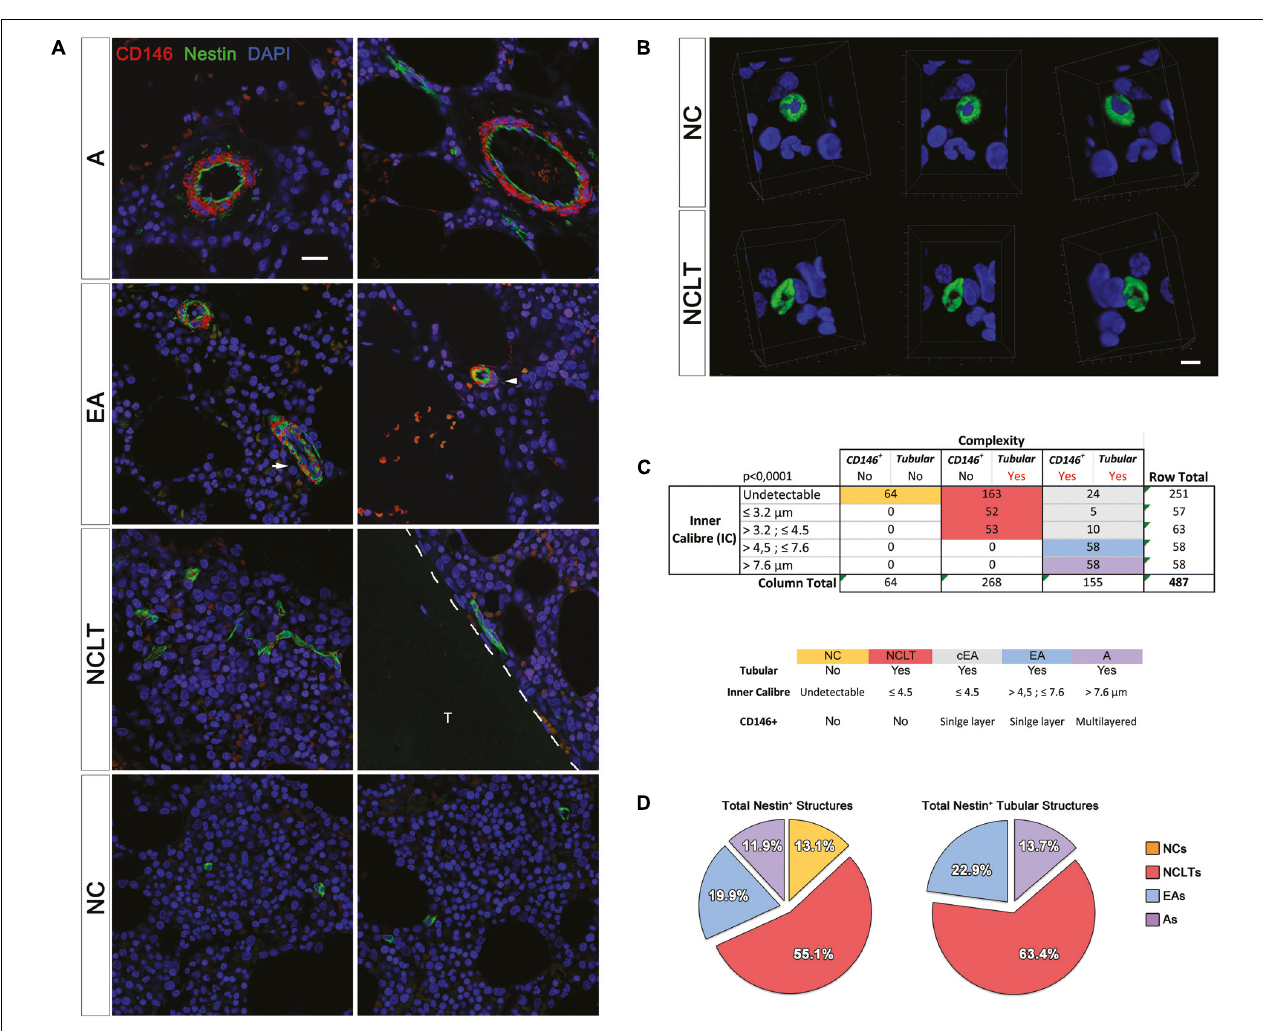
FIGURE 3 | Classification and quantification of NESTIN + vascular structures. (A) Single optical sections allowed accurate measurement of the inner caliber (IC) of NESTIN + (green) structures and the correlation to the CD146 (red) perivascular cells (scale bar = 20 µ m, T = trabecula). (B) Due to the tiny lumens, several transversal sections of capillaries could be confused with single NESTIN + cells. In these cases, a 3D-reconstruction was applied to discriminate single cells (NC) showing spheroidal and “no-tubular” NESTIN + (green) structure surrounding a DAPI + (blue) nucleus. NESTIN + capillary-like tubes (NCLT) revealed their “tubular” nature, showing the hollow fiber-like appearance (scale bar = 5 µ m). (C) The contingence ( p < 0.001) has been analyzed by a 5 × 3 table, including IC quartiles and complexity. We grouped NESTIN + structures in arteries (IC > 7.2 µ m, complexity: Y/Y, purple box), arterioles (4.6–7.2 µ m, complexity: Y/Y, pale blue box) and capillaries (IC < 4.6 µ m, complexity: N/Y). Sub-endothelial perivascular cells were also detected in about 30% of < 4.6 µ m micro-vessels, which we believe to be arterioles with apparent IC < 4.6 µ m due to compression or sectioning artifacts [white arrow in panel (A) , gray box in panel (B) ]. Confocal images showing segregated expression of NESTIN (green) and CD146 (red) in arterial BMEC and sub-endothelial adventitia of bone marrow arteries, respectively. EA showed selective NESTIN/CD146 expression in more interdigitating cells or cells encircled by single pericytes (white arrowhead). (D) NCLTs resulted the most frequent NESTIN + microvascular